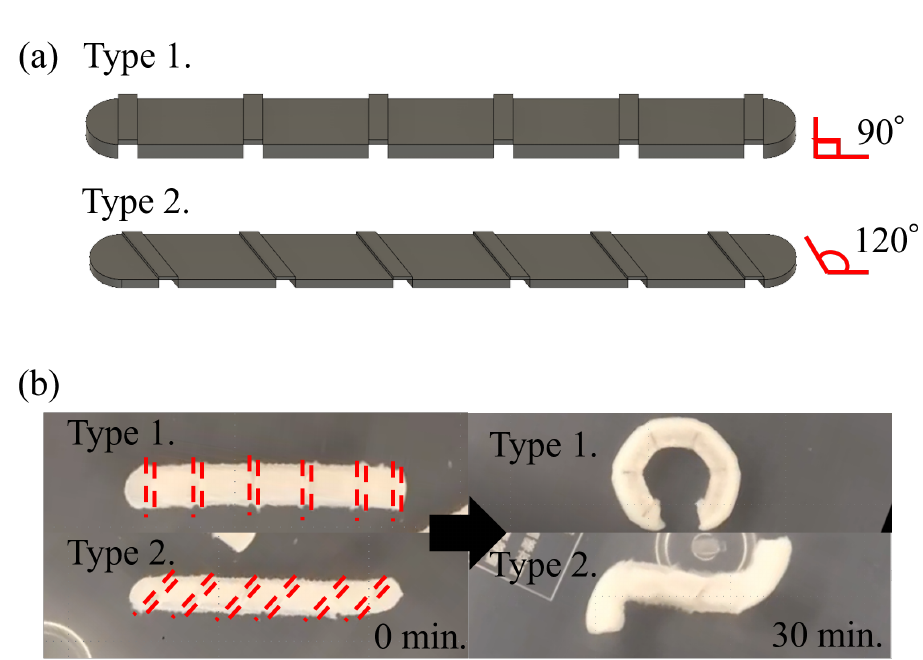
Figure 8. The 4D printing of worm models with two different hinge structures. ( a ) The design of the two different hinge structures. Type 1 is a transverse hinge, whose angle between the hinge direction and the longitudinal direction of the worm is 90 degrees. Type 2 is a tilted hinge, whose angle between the hinge direction and the longitudinal direction of the worm is 120 degrees. ( b ) The before and after photographs of the two different worms. Type 1 is the transverse hinge bent until it came around. Type 2 is the tilted hinge twisted until it formed an S shape.